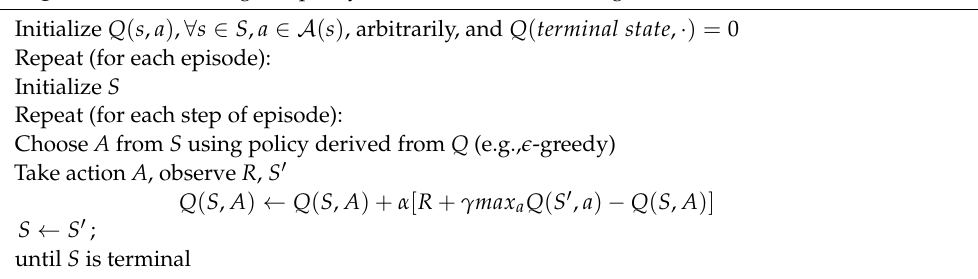
Algorithm 1 Q-learning (off-policy TD control) for estimating π ≈ π